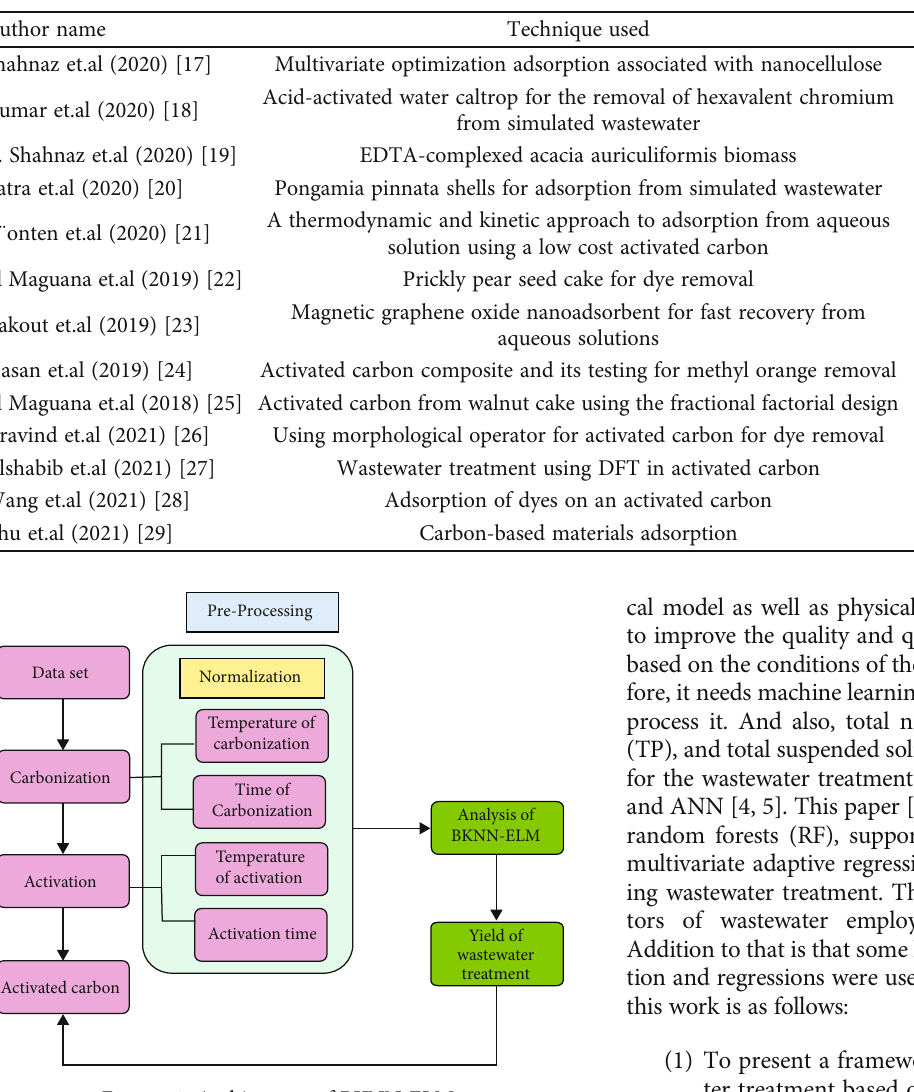
Table 1: Survey on techniques used in wastewater treatment.